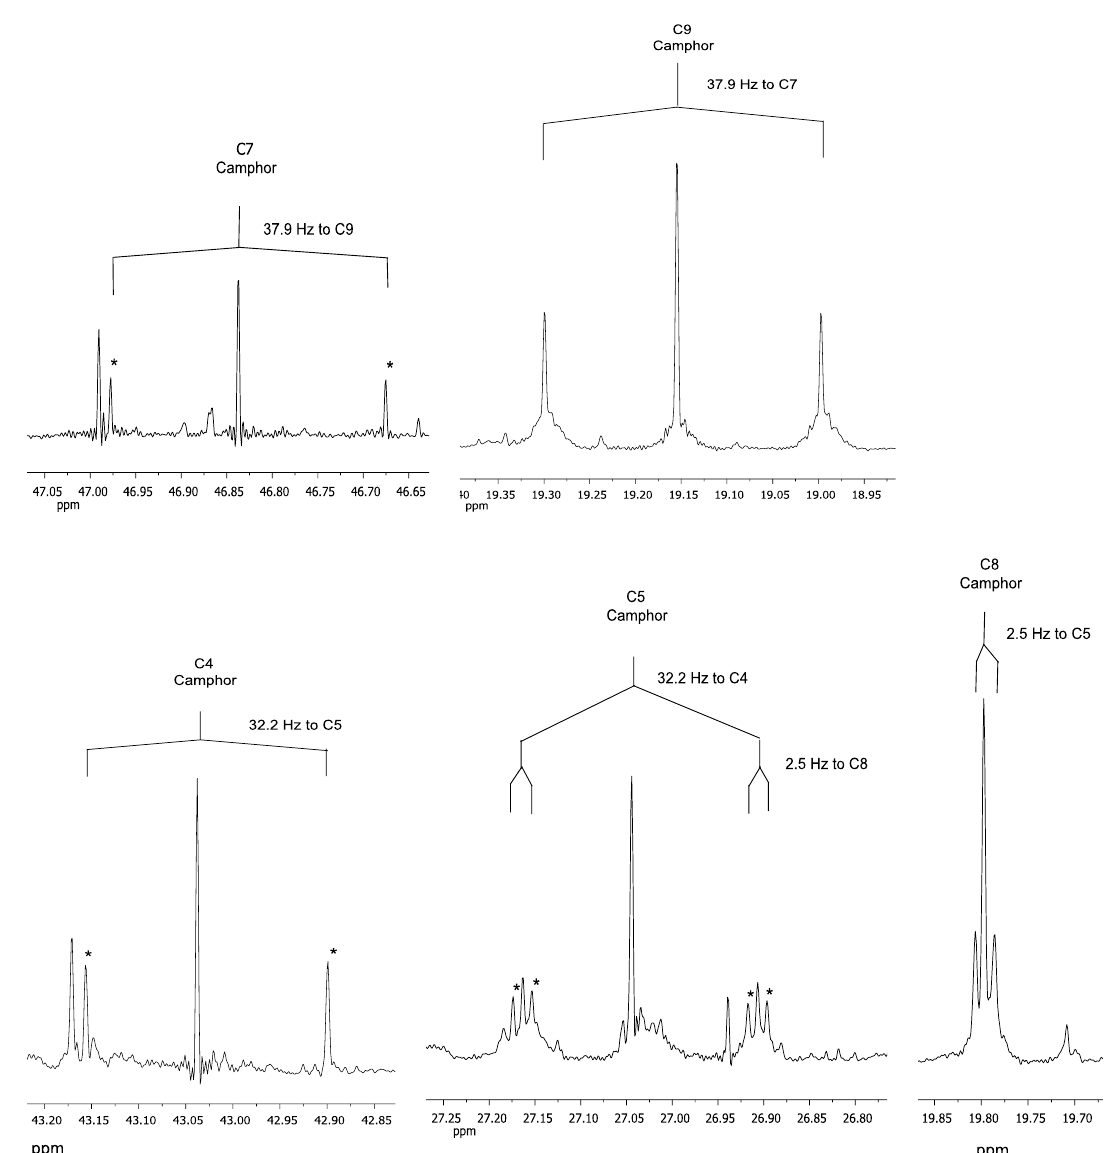
Figure 5. 13 C NMR camphor signals, chloroform-d leaf essential oil extract from spike lavender after incorporation of 13 CO 2 (pulse 5.2 h, chase 192 h). * indicate the satellite signals of the carbon atoms under study.